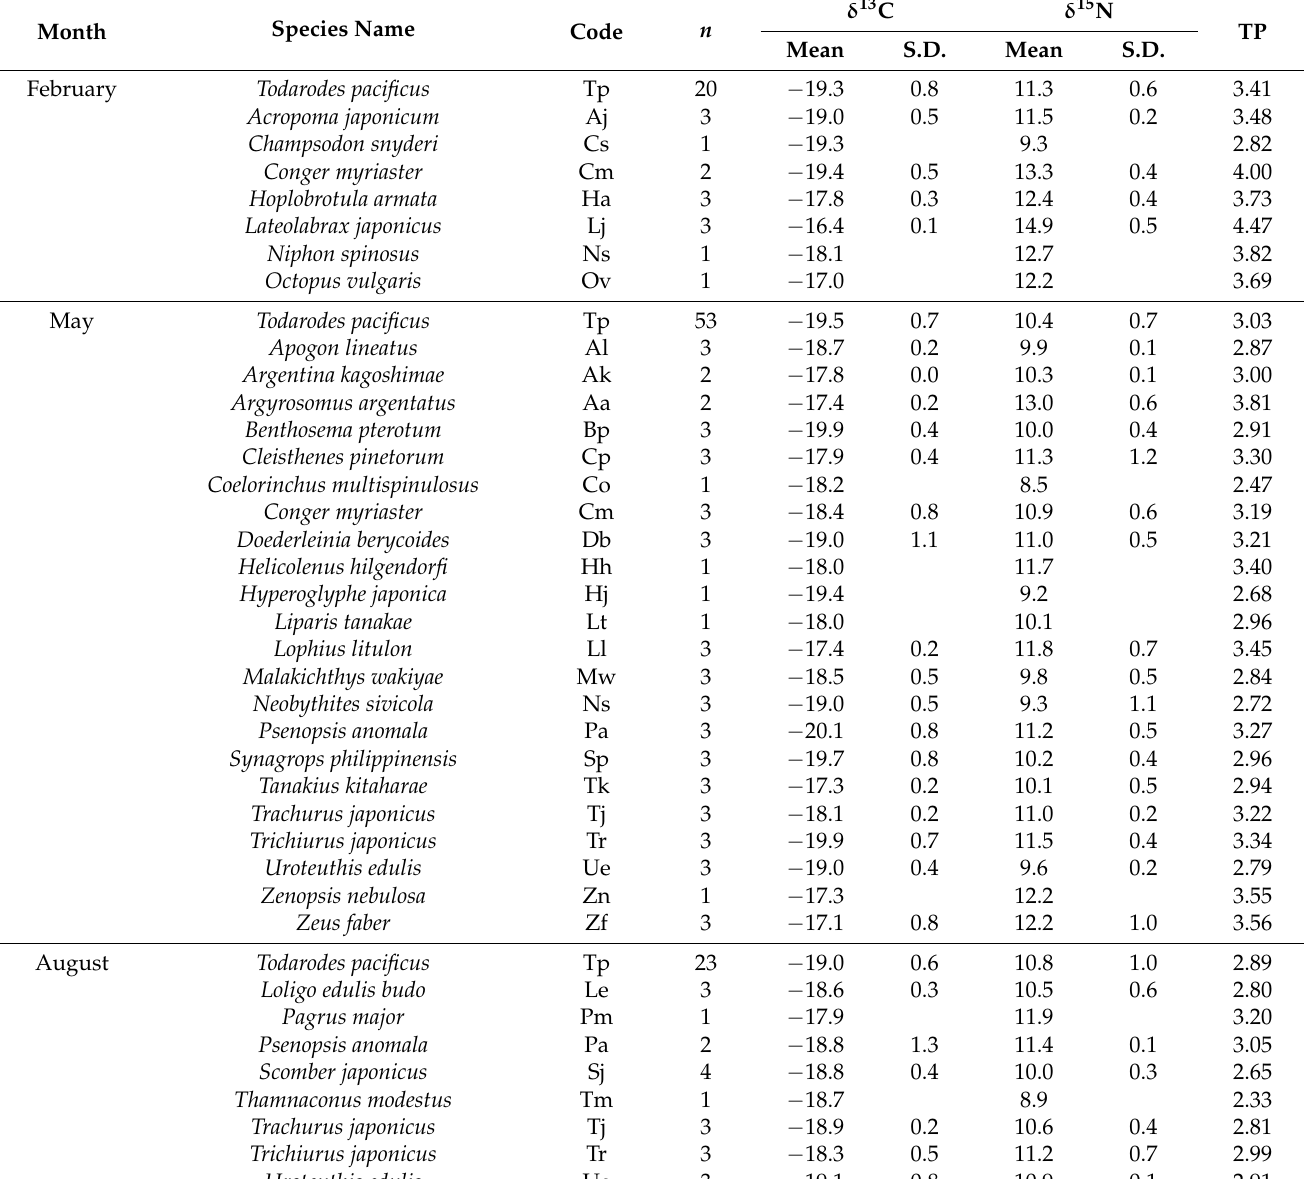
Table 2. Mean δ 13 C and δ 15 N values and trophic position (TP) of common squid Todarodes pacificus and other fish consumers collected during February, May, and August 2021 in the South Sea of Korea (#104, #106, #111, and #224). Data represent means ± 1